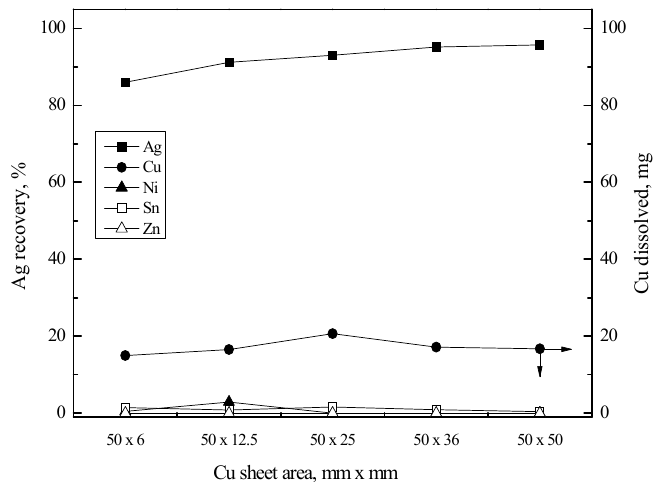
Figure 10. Effect of Cu sheet area on the Ag recovery by cementation with Cu sheet. Stirring speed = 200 rpm; temperature = 80 °C; time = 60 min; copper sheet = 50 × 6, 50 × 12.5, 50 × 25, 50 × 36; 50 × 50 mm 2 .